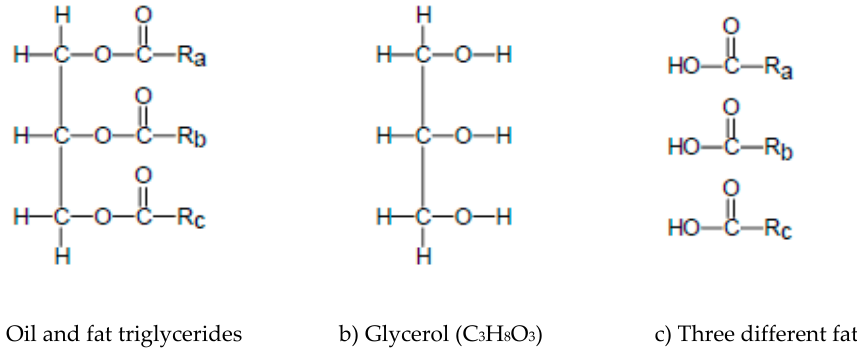
Figure 2. ( a ) The common chemical structure of oil and fat triglycerides, ( b ) the glycerol molecule and ( c ) symbolization of three different fatty